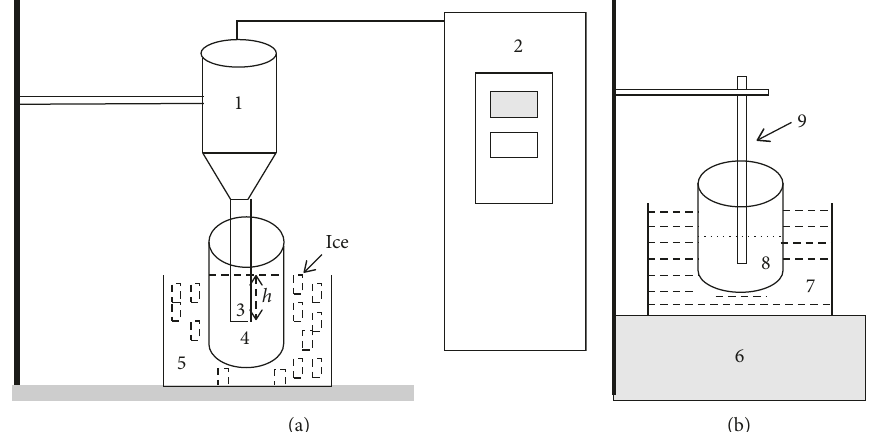
Figure 1: Experimental setup for ultrasound treatments (a) and thermal processing (b). 1: ultrasound transducer; 2: ultrasonic generator; 3: ultrasound probe (19mm); 4: glass vessel; 5: ice bath for a cooling ( h ) depth of probe into the sample (25mm); 6: hotplate; 7: boiling water bath; 8: bayberry juice samples; 9: